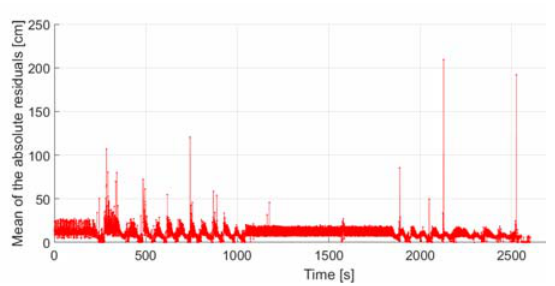
Figure 10. Internal error of UWB positions measured by the mean of the absolute residuals